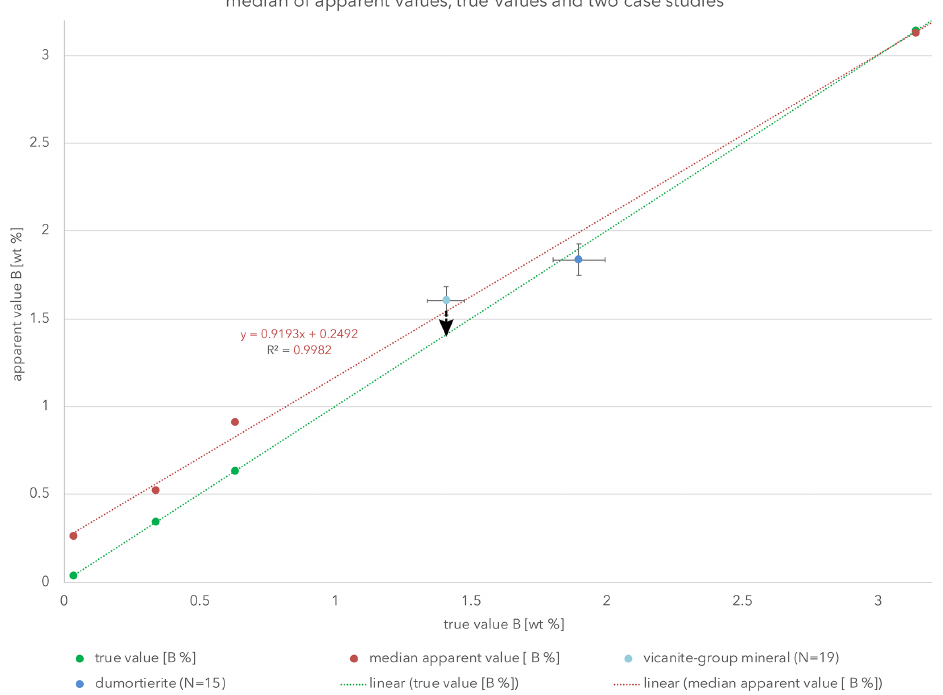
Figure 3. Linear trend lines (red) for the apparent values and (green) for the true values. The red line crosses the y axis at 0.249, which should be seen as the DL for boron on LDEB. The arrow at the vicanite group mineral data point indicates the correction of B. Table 3. Apparent values of boron (in wt%) measured using the two different standard materials. The certified (or informative, denoted by ∗ ) value is again given for comparison. Single values are shown in Supplement Table